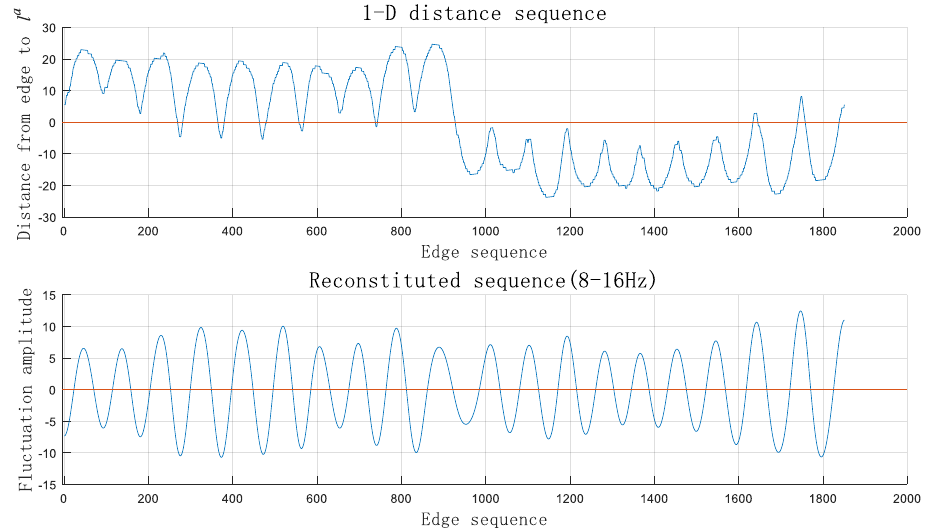
Figure 7. The waveform of the contour sequence and waveform after 8–16 Hz reconstruction 2